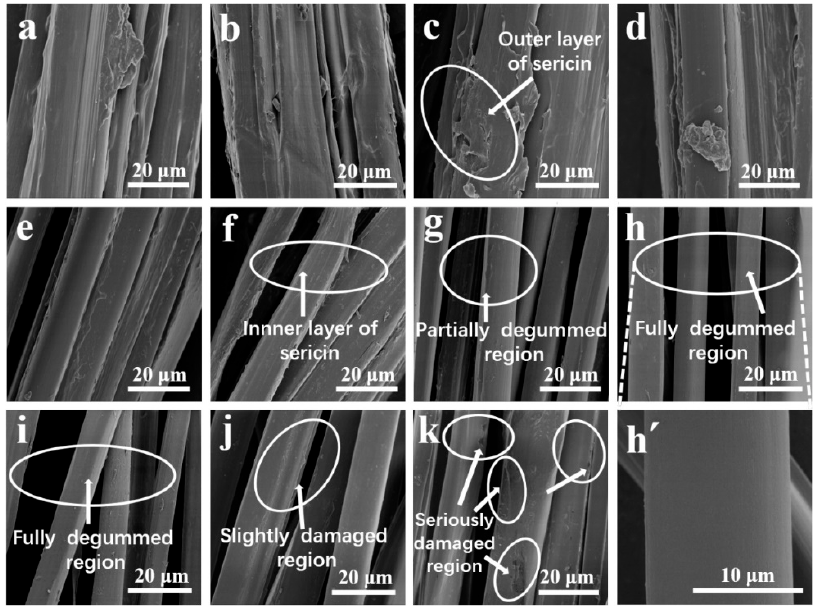
Figure 3 . SEM images of silk fiber surfaces. ( a ) Non-degummed raw silk fibers, ( b–j ) degummed with 0.01, 0.05, 0.1, 0.3, 0.5, 1.0, 3.0, 4.0, and 6.0 g/L papain, ( k ) degummed with 0.5 g/L Na 2 CO 3 , ( h’ ) magnified image of ( h ). Scale bars: ( a – k ) 20 μ m, ( h’ ) 10 μ m.